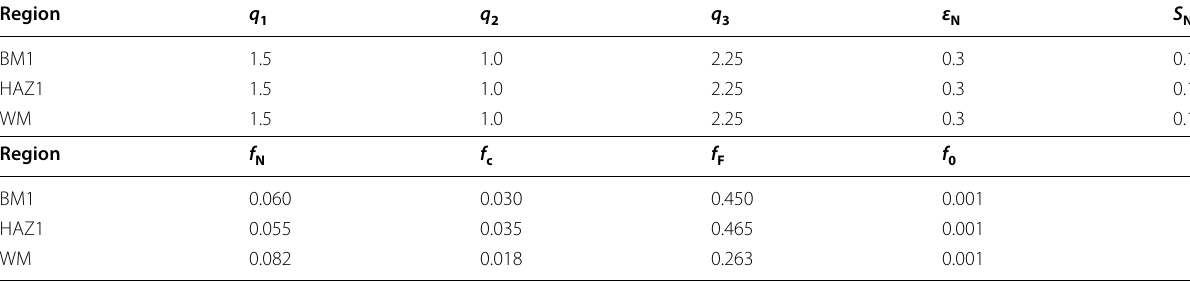
Table 2 GTN parameters of BM, HAZ and WM regions in dissimilarly welded joint Region q 1